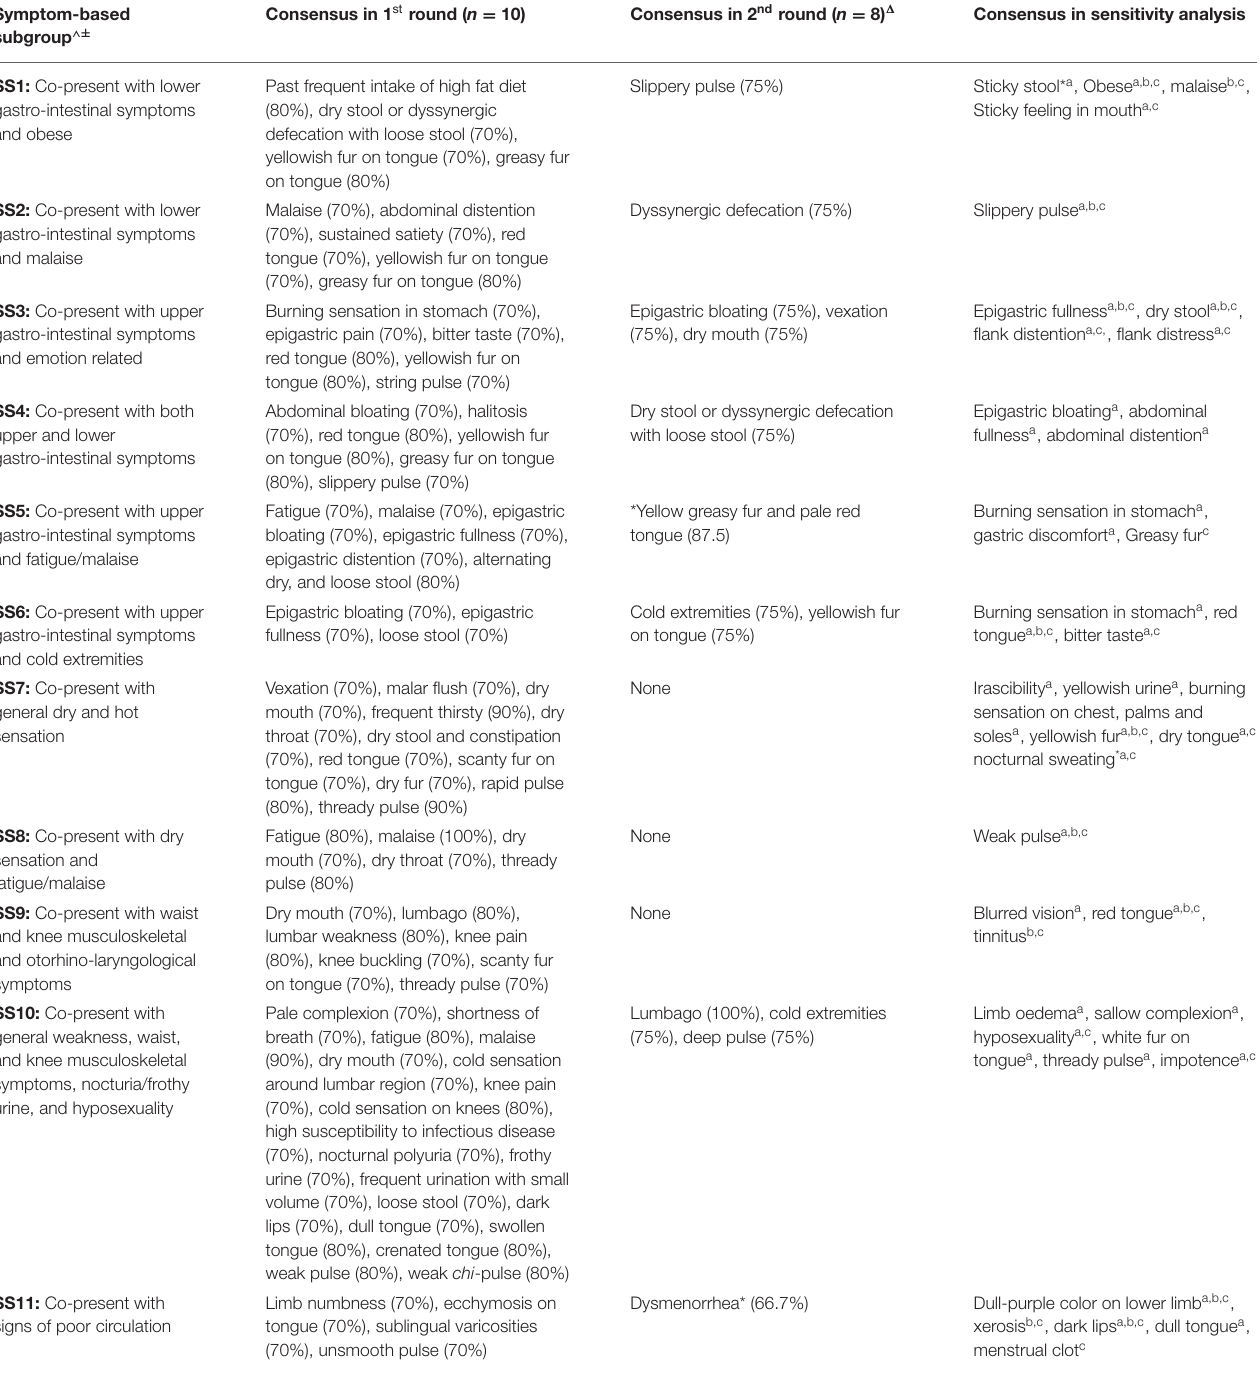
TABLE 4 | Delphi consensus